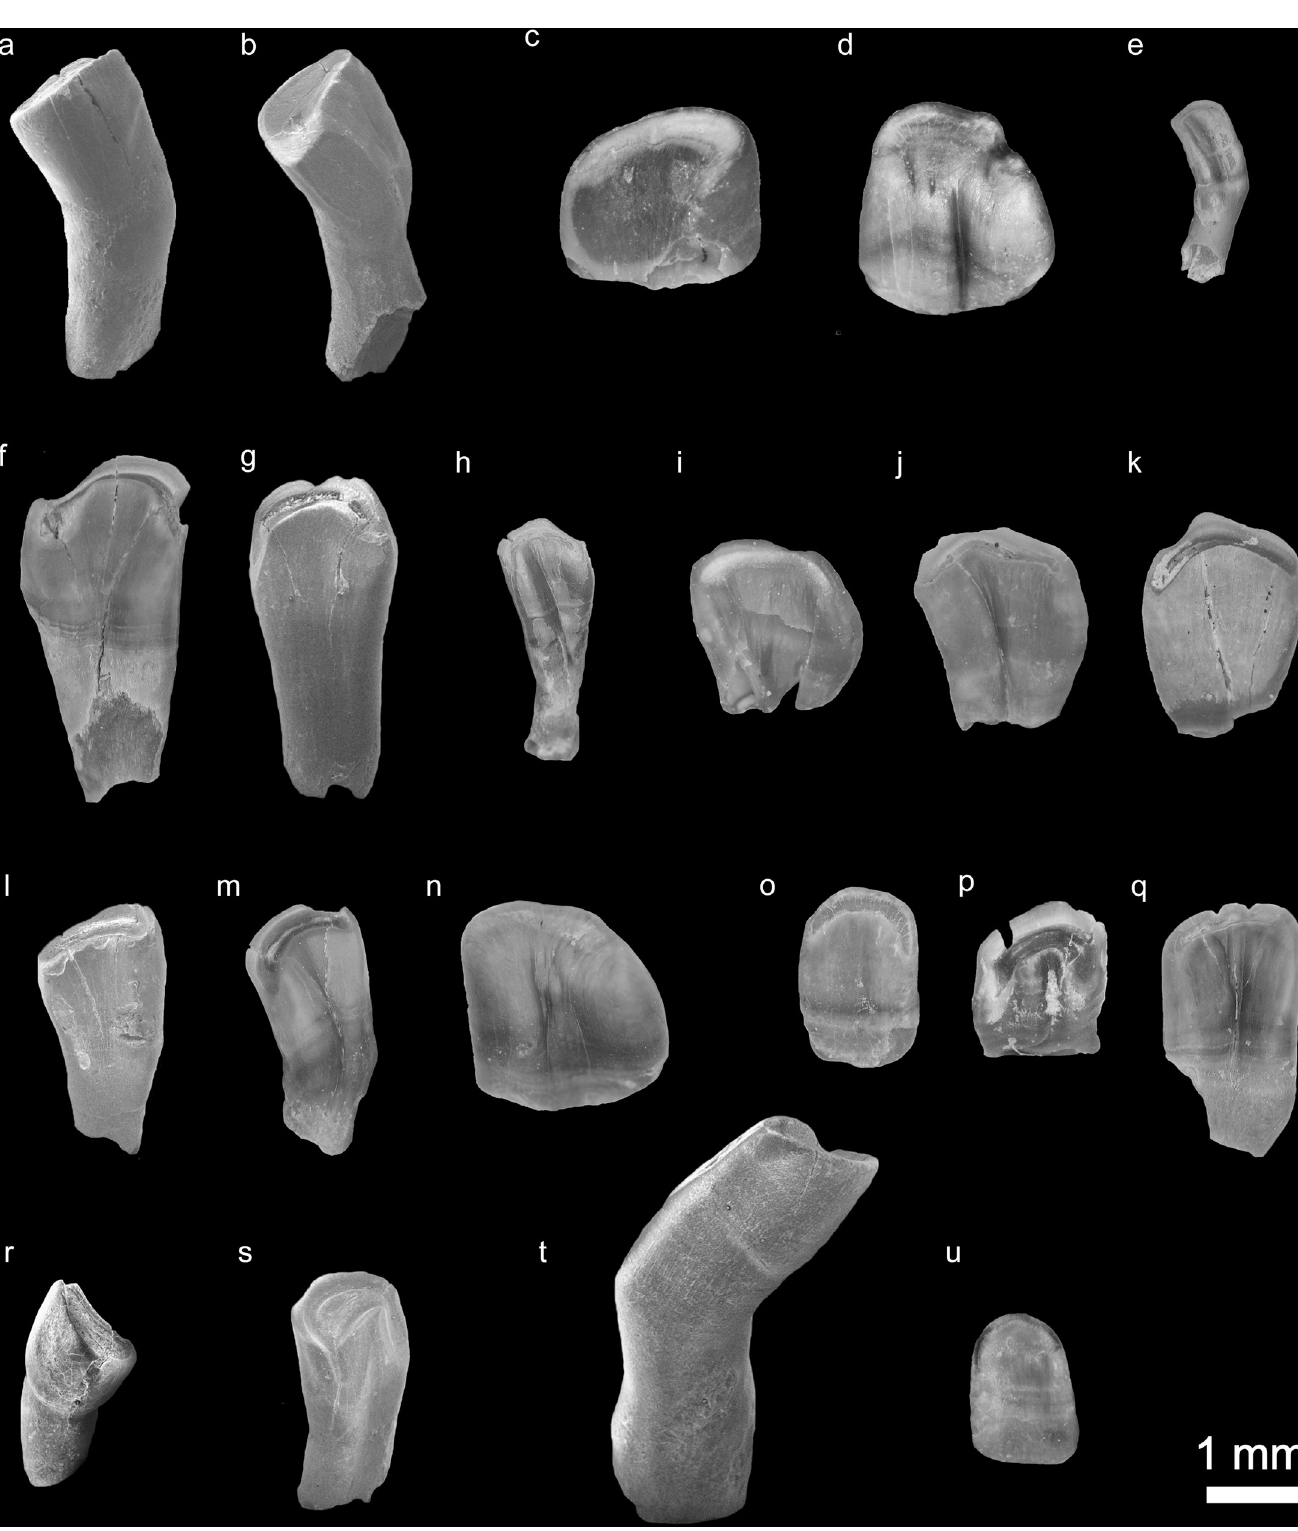
PLOS ONE | https://doi.org/10.1371/journal.pone.0215543 May 8,